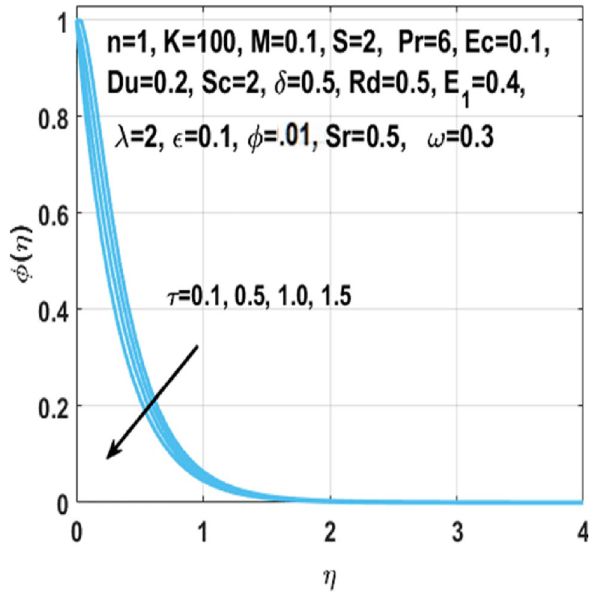
Figure 8. Impact of τ on φ(η) .